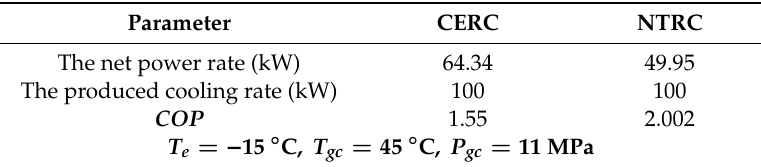
Table 8. CERC and NTRC energy performance